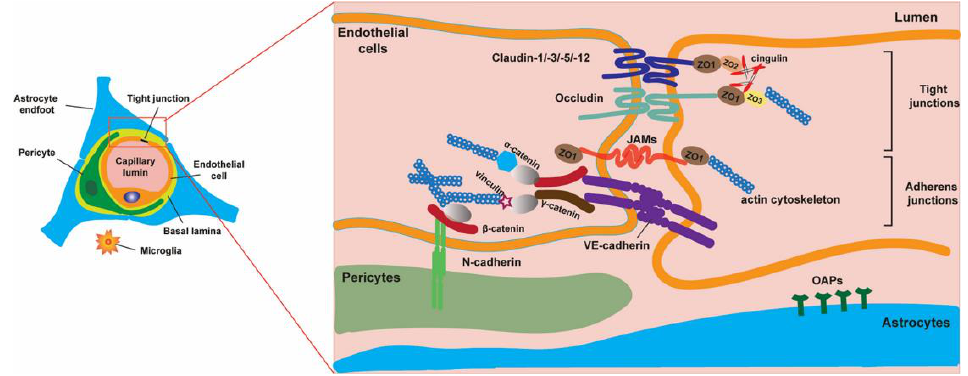
Figure 1. The cellular and most significant molecular components of the blood–brain barrier as part of the neurovascular unit (Reprinted with permission from Kadry, H., Noorani, B. and Cucullo, L. A blood–brain barrier overview on structure, function, impairment, and biomarkers of integrity. Fluids Barriers CNS 17 , 69 (2020). https://doi.org/10.1186/s12987-020-00230-3) [4].